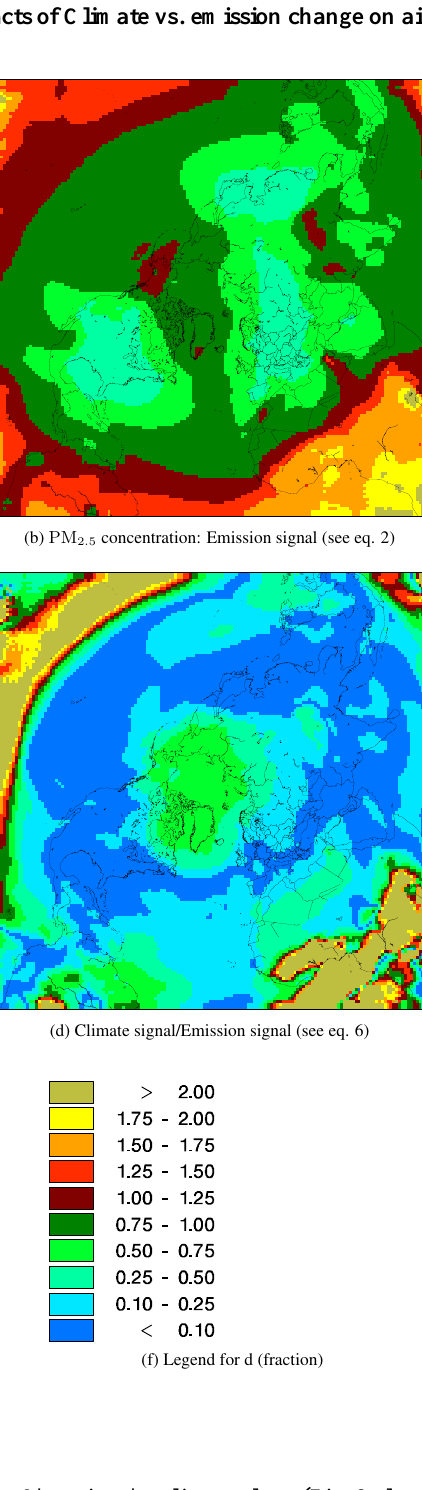
changes in total N concentration are shown. This figure is displayed similarly to Figs. 4, 7 and 5. Since total N contains both NH x and NO y the total N distribution is dependent on chemical reactions. Therefore the total signal displayed in Fig. 8c is like in the case of O 3 and the total PM 2 . 5 is different from the addition of Fig. 8a and b.